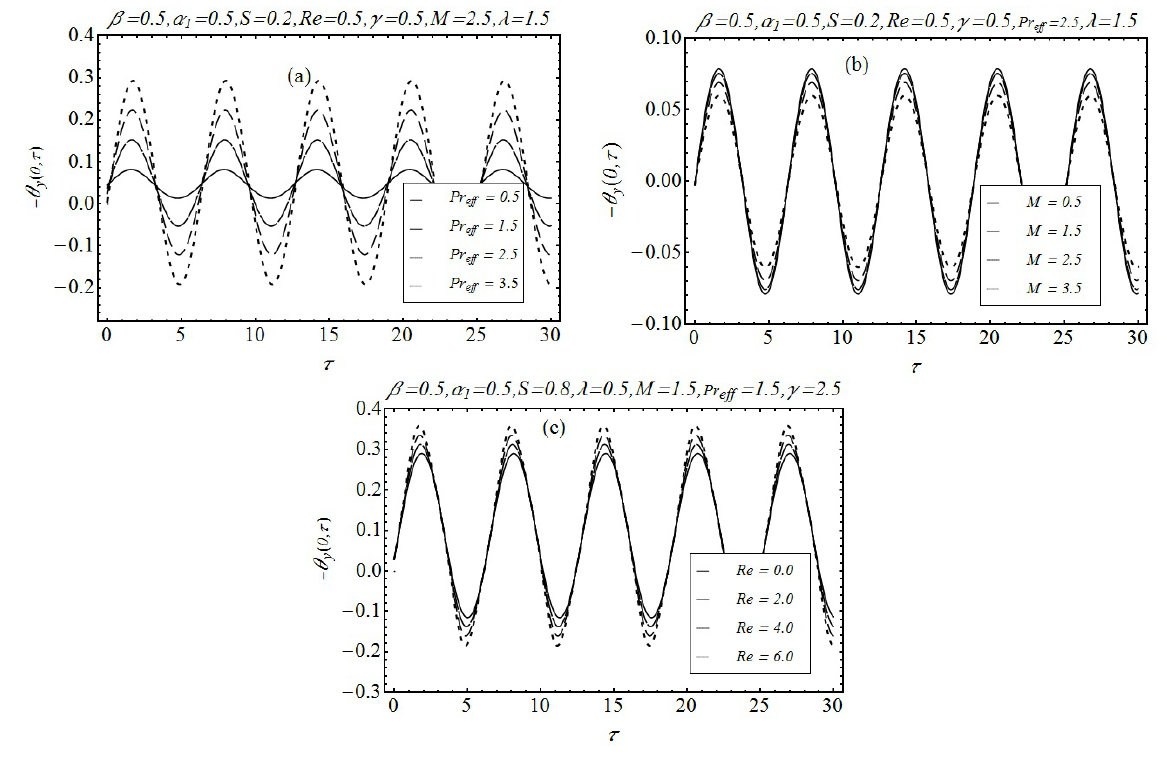
Figure 16: Time series of the effective local Nusselt number Re −1/2 x Nu * x (a) Effects of Pr , (b) Effects of M (c) Effects of Re